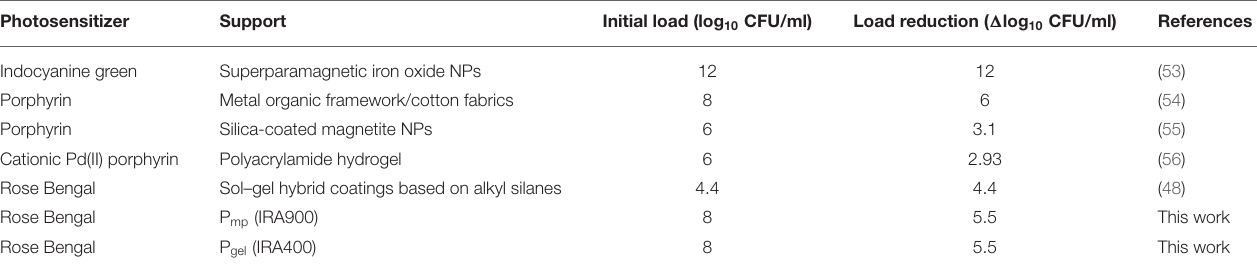
TABLE 3 | Recent examples reported in literature of Escherichia coli inactivation caused by photosensitizing materials.